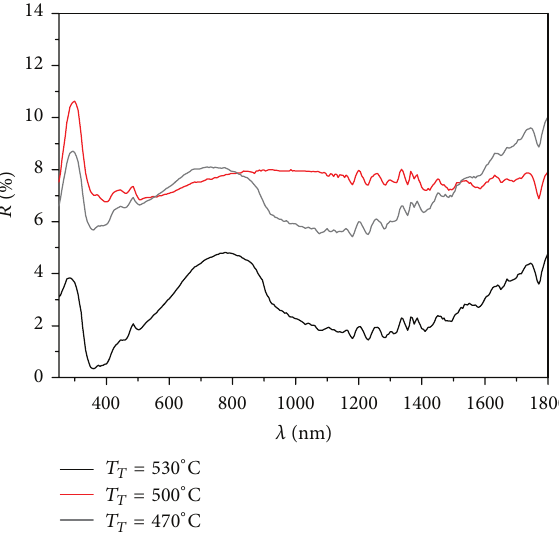
Figure 2: Reflectance spectra of the as-grown iron ditelluride layers. optimized layer, elaborated at 500 ∘ C, has the highest values of rms and average